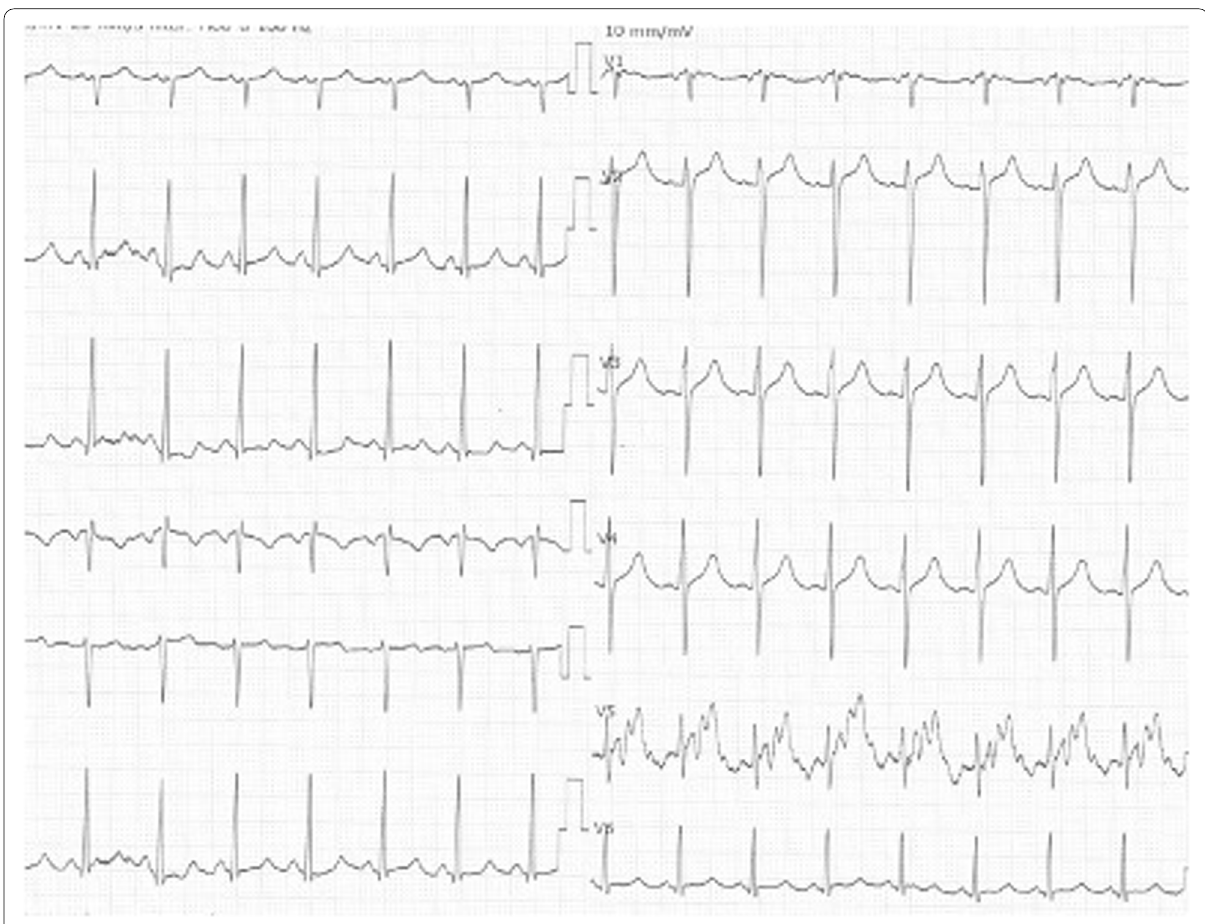
Fig. 3 Electrocardiogram after surgical